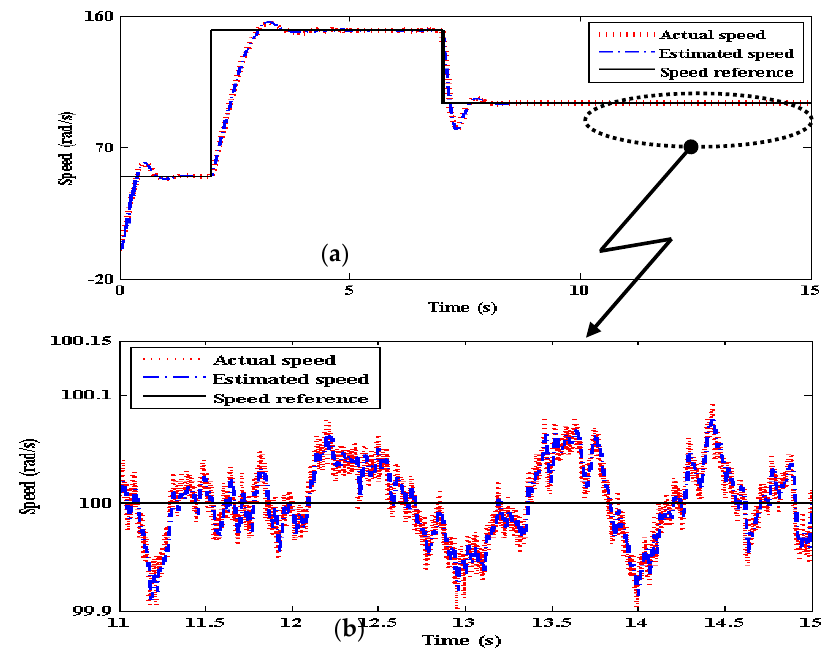
Figure 15. ( a ) Estimated speed of SMLO 2 ( b ); and zoomed version of ( a ).